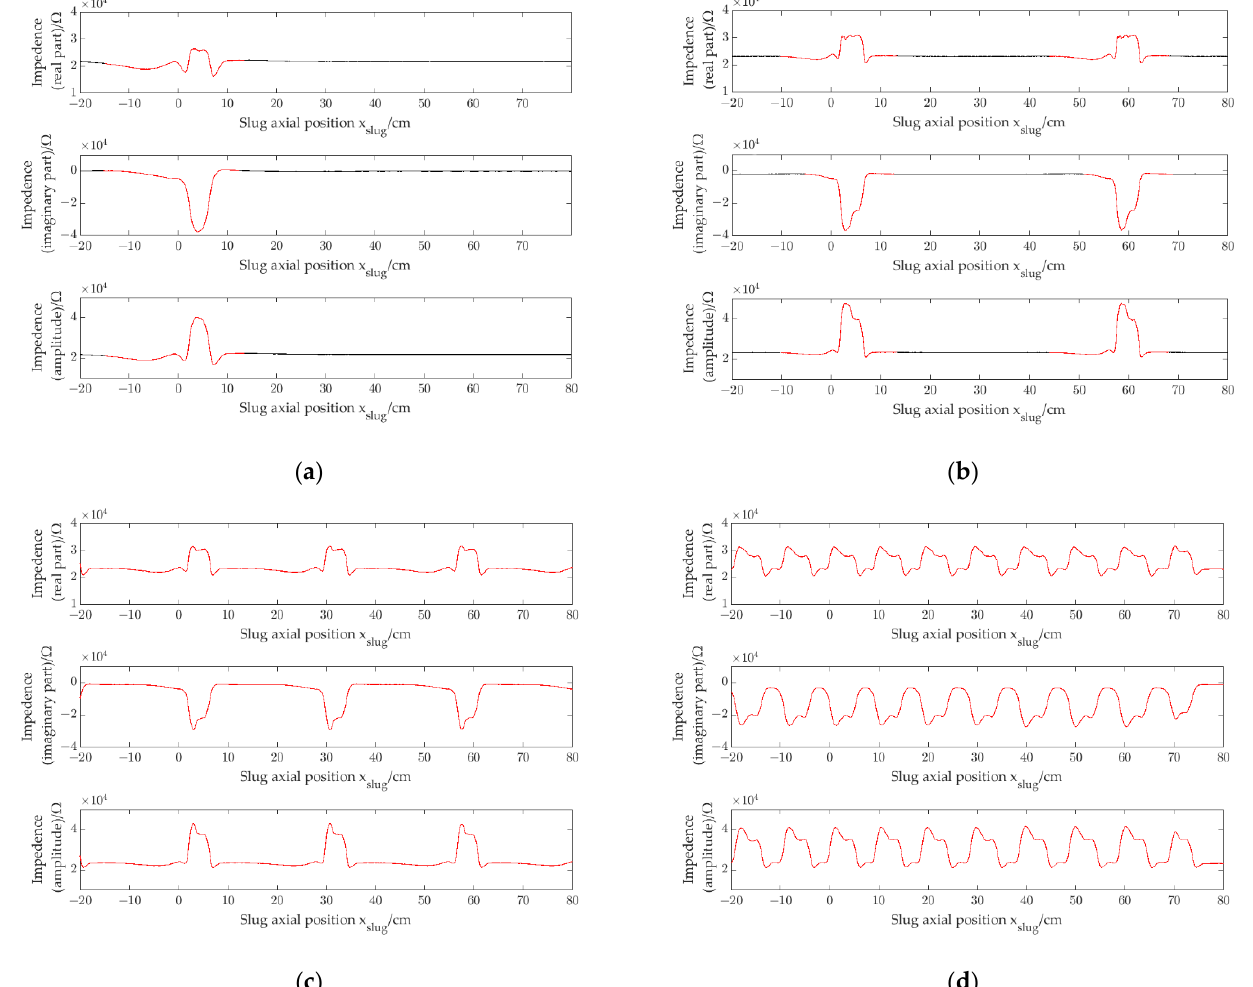
Figure 11. Impedance signals of slug flow, i.d. = 2.48 mm: ( a ) single slug; ( b ) signal separation distance is 56 cm ( ρ re = 0.91, ρ im = 0.95 and ρ am = 0.91); ( c ) signal separation distance is 27 cm ( ρ re = 0.89, ρ im = 0.95 and ρ am = 0.89); ( d ) signal separation distance is 9 cm ( ρ re = 0.38, ρ im = 0.47 and ρ am = 0.38 )